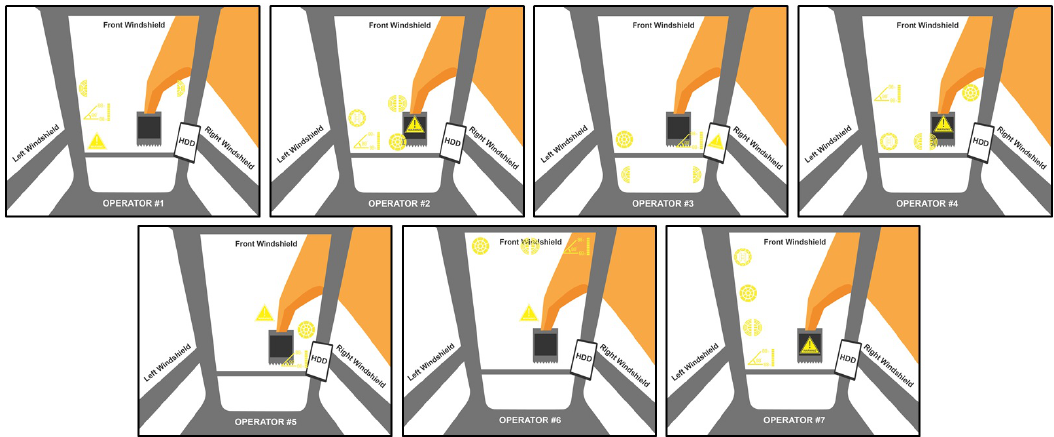
Figure 19. These images illustrate which visualization concepts that the operators preferred to have and where the information should be presented on the windshield. All the operators included at least three visualization concepts to be presented on the windshield. Note that the visualization concepts shown here are the ones before we revised